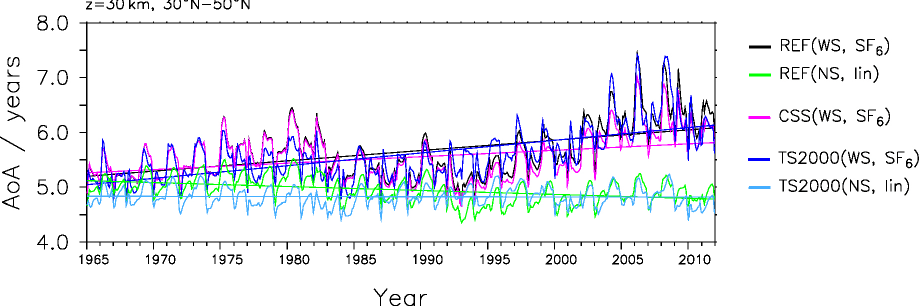
Figure 6. AoA (at 10hPa, averaged over 30–50 ◦ N) time series and linear regression of sensitivity experiments TS2000(WS, SF 6 ), TS2000(NS, lin), and CSS(WS, SF 6 ) shown in dark blue, light blue, and pink, respectively. The reference simulations REF(WS, SF 6 ) and REF(NS, lin) are shown in black and green,